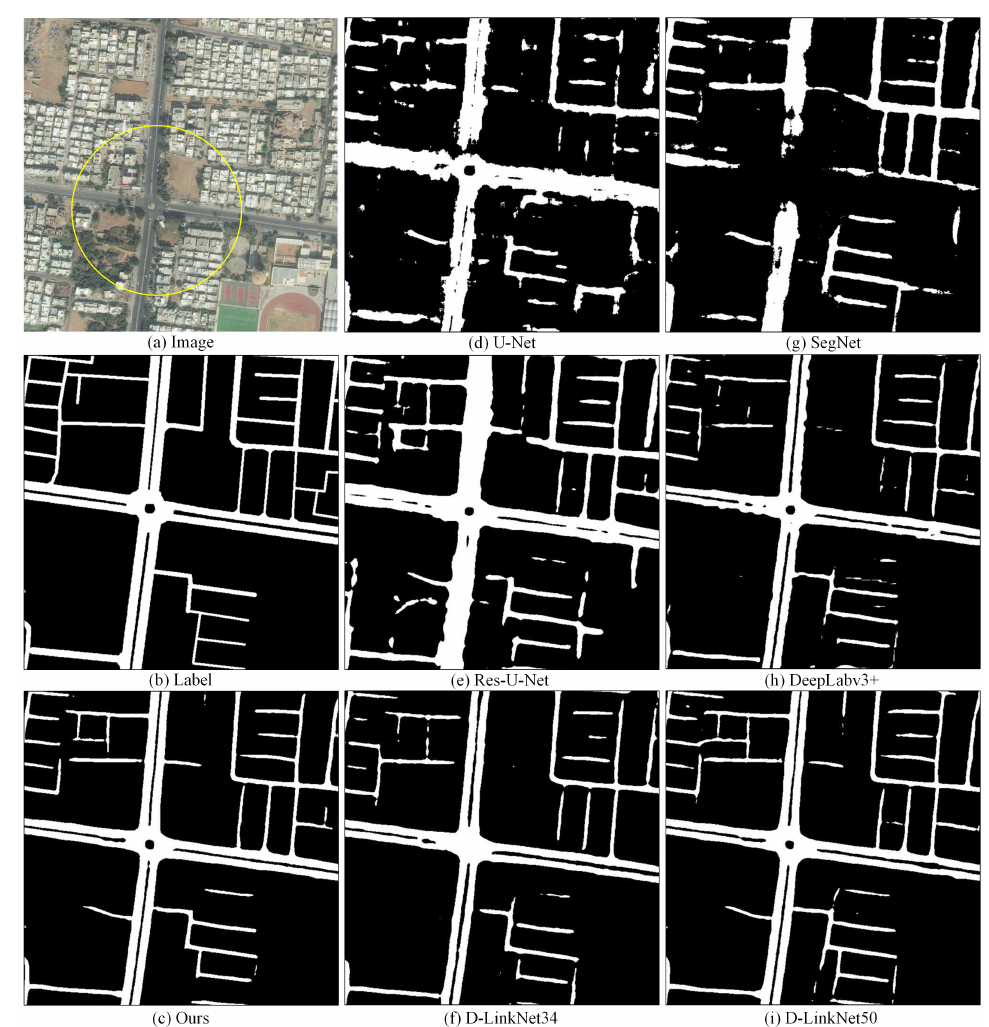
Figure 12. Local detail comparison on the DeepGlobe dataset. Subparts ( d – i ) show the results of the related methods corresponding to the area in the original image ( a ) marked with yellow. Subparts ( b , c ) are the ground truth and our